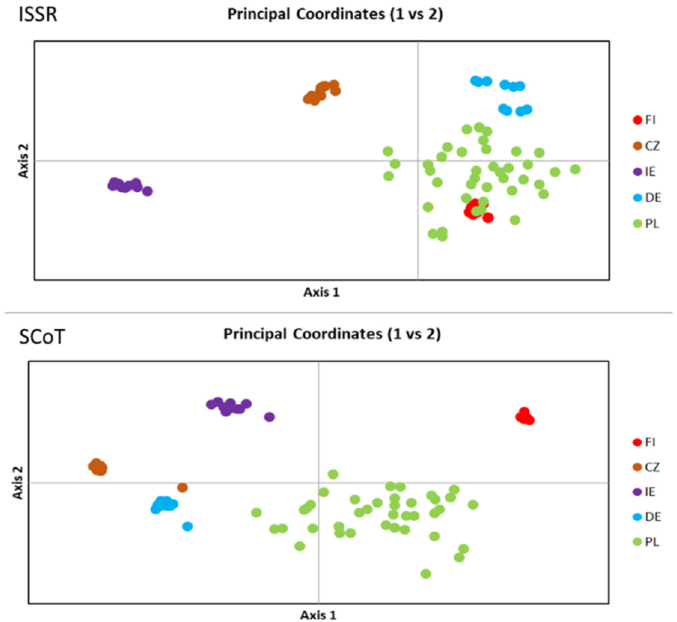
Figure 2. The result of PCoA analysis preformed based on genetic distance among B. graminis f. sp. avenae isolates.